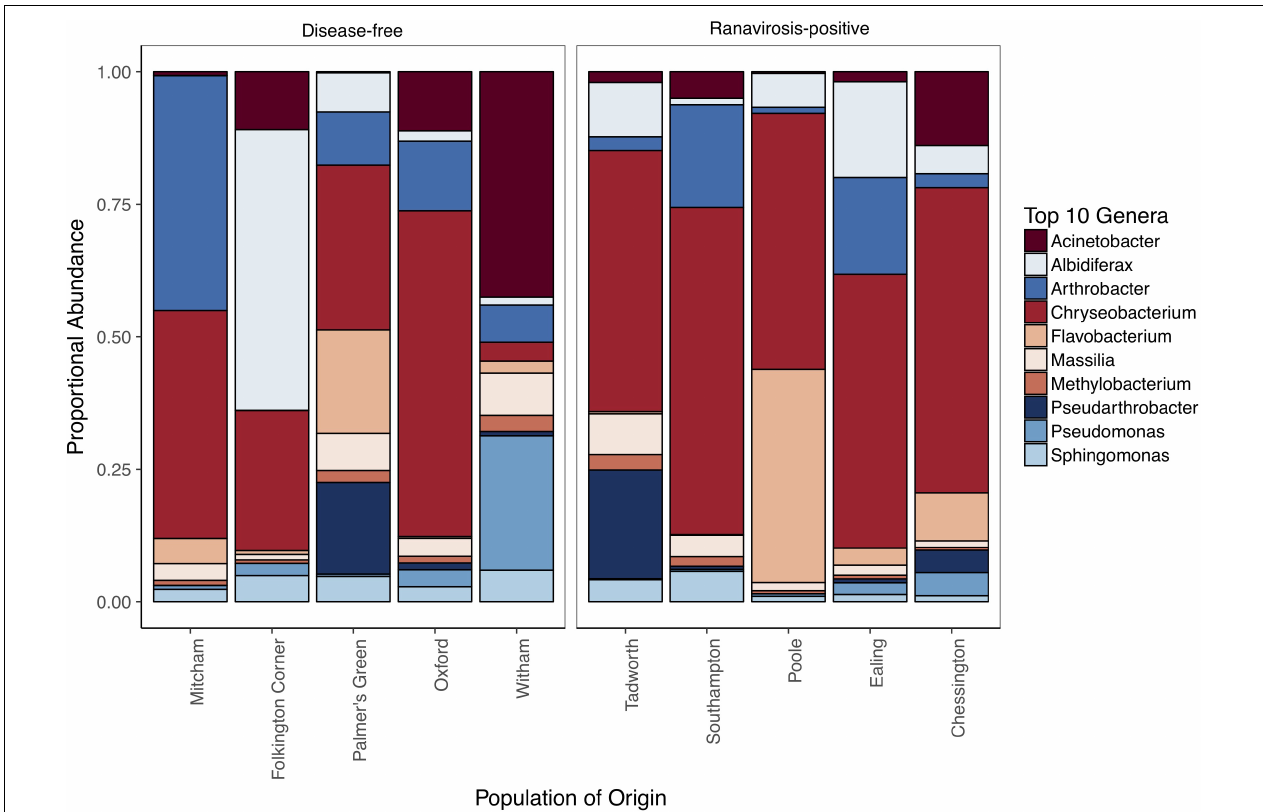
FIGURE 2 | Relative abundance of the top 10 most abundant genera at each of our 10 sampled populations. Populations are grouped by disease history status to allow for visual comparison of abundance